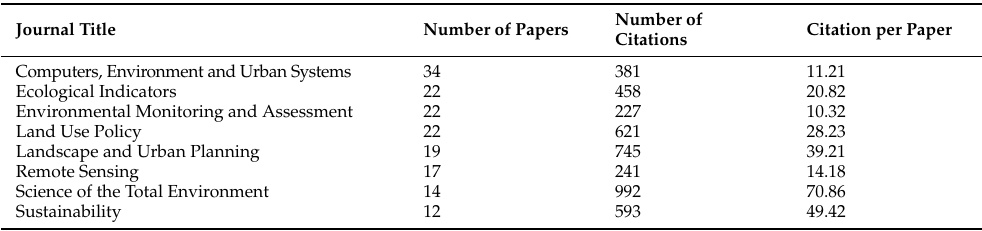
Figure 4. Major methodological codes found in the LULCC studies.